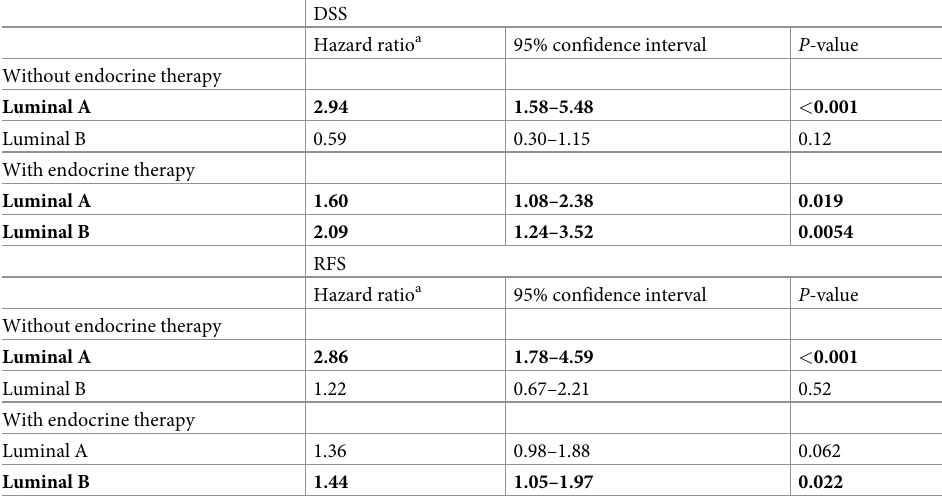
a SLC20A1 high group’s hazard ratio to SLC20A1 low group adjusted using age as a confounding factor as estimated using Cox proportional hazard model. Significant differences are shown in